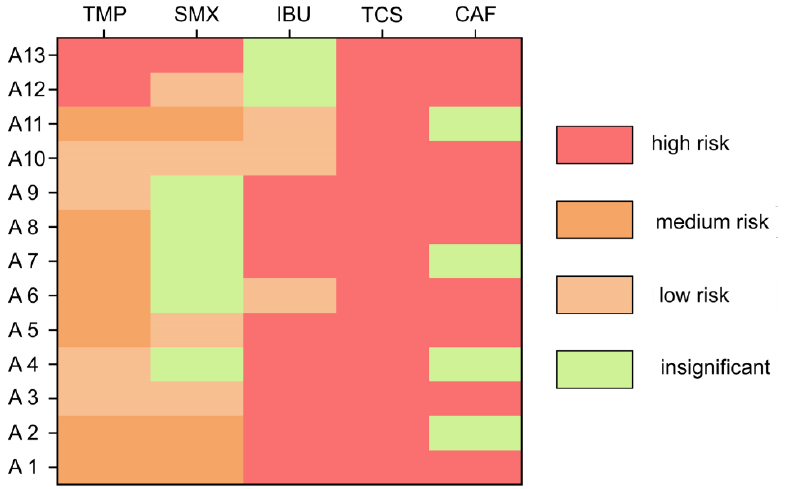
Figure 5. Ecological risks of PPCPs in the sediment samples of the North Canal Basin.